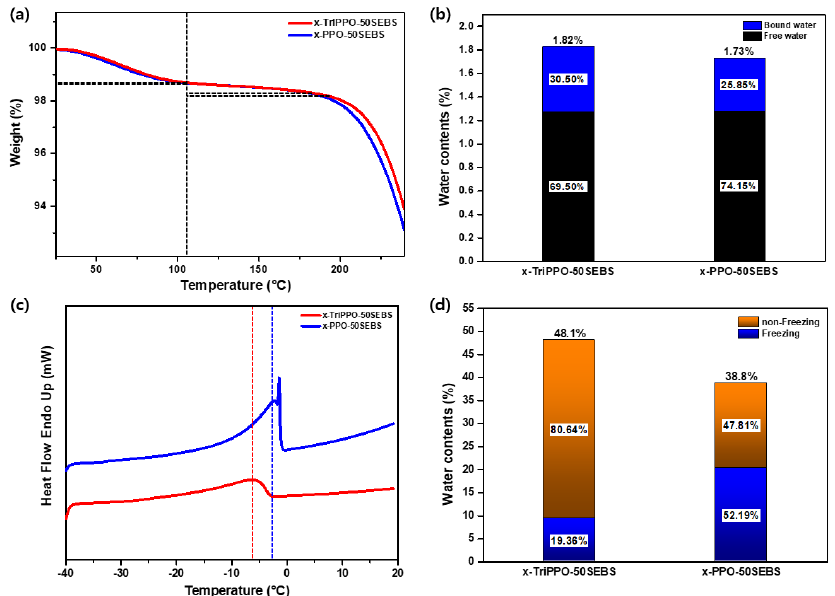
Figure 5. ( a ) The crosslinked PPO − SEBS membranes measured from 30 to 250 °C in TGA plots; ( b ) The relative ratio of free water and bound water in the crosslinked PPO − SEBS membranes; ( c ) The crosslinked PPO − SEBS membranes measured from 40 to 20 °C in DSC plots; and ( d ) The relative ratio of freezing bound water and non-freezing bound water in the crosslinked PPO − SEBS membranes.